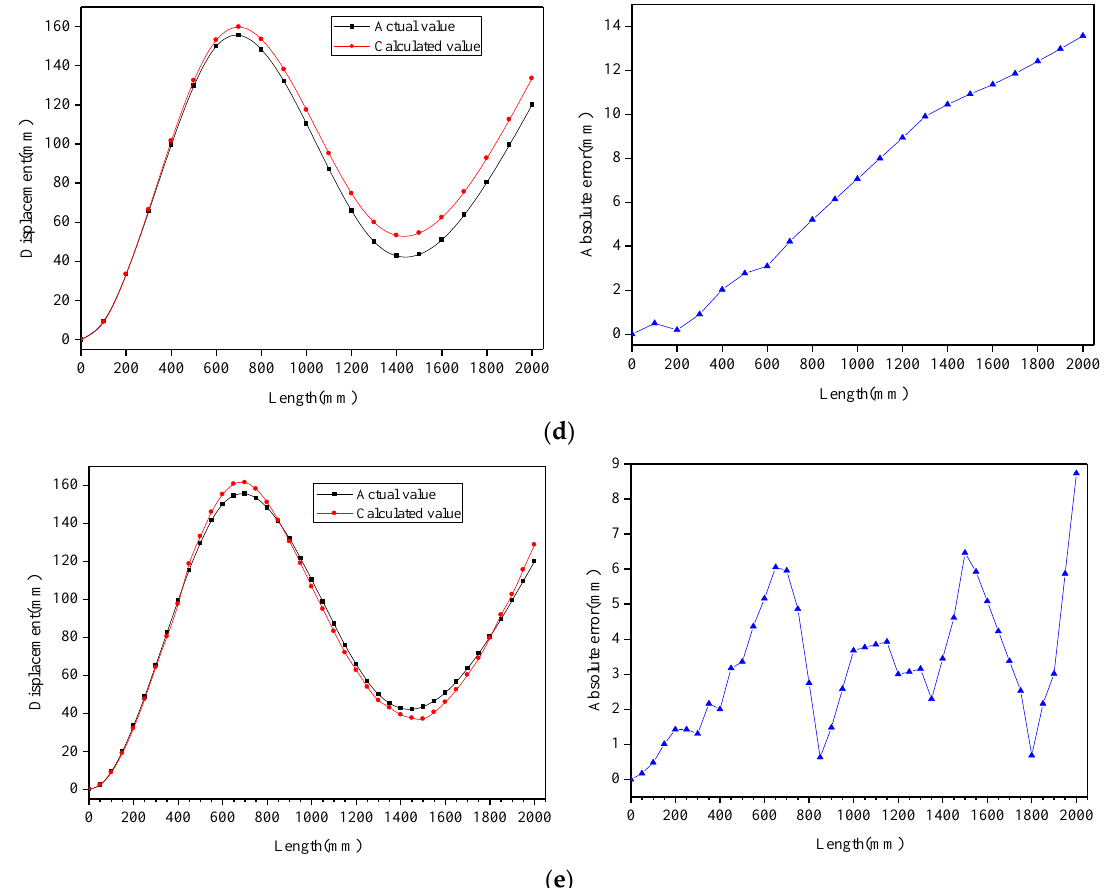
Figure 13. Comparison between calculated displacement and actual displacement of measuring points at different intervals, as well as absolute error of reconstructed measuring points: ( a ) l = 400 mm; ( b ) l = 300 mm; ( c ) l = 200 mm; ( d ) l = 100 mm; ( e ) l = 50 mm.